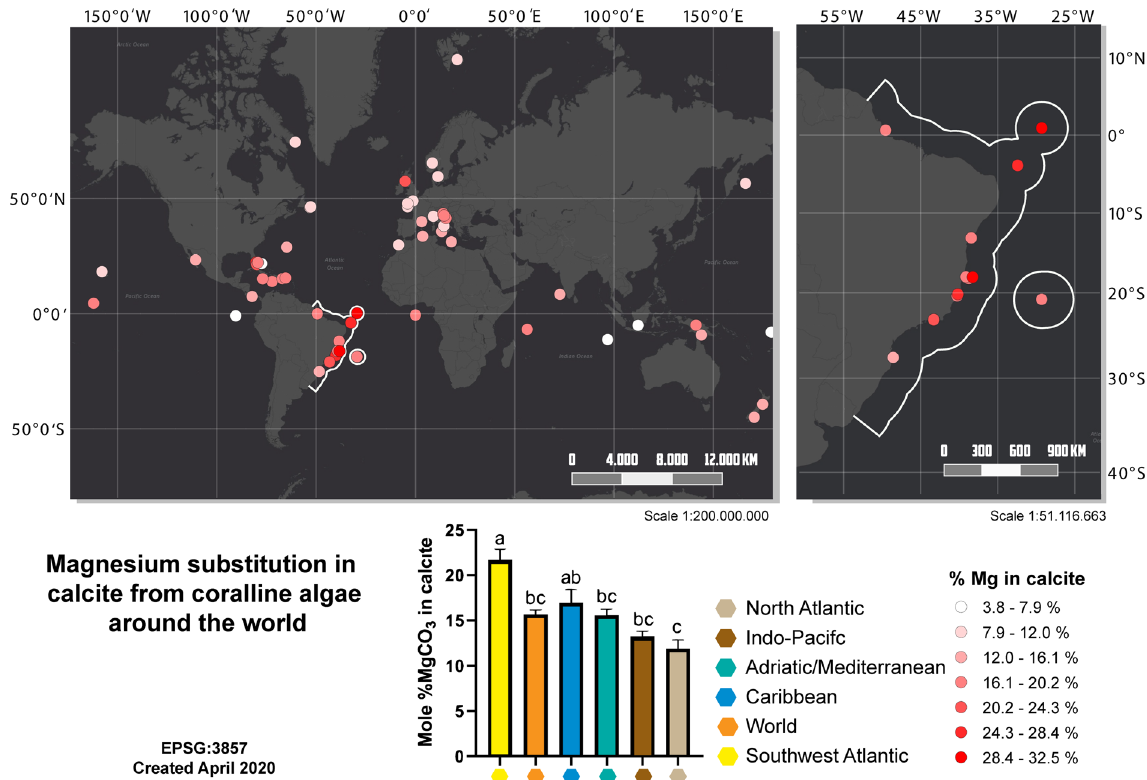
Figure 2. Map of world distribution of % Mg in calcite in coralline algae from four regions (North Atlantic Ocean, Indo-Pacific Ocean, Adriatic/Mediterrean Sea, Caribbean and Southwest Atlantic Ocean; upper left in the figure) ranging from 4 to 33% Mg in calcite; a detailed map of % Mg in calcite in coralline algae species analyzed in this study along the Brazilian shelf (upper righ in the figure); mean % Mg in calcite in coralline algae and standard deviation in several regions of world. Different letters are used to indicate statistically differences (p < 0.05) obtained through post-hoc Dunn’s test after the Kruskal–Wallis analysis (bellow in the figure). Both maps maps were obtained from ESRI database (https:// servi ces. arcgi sonli ne. com/ arcgis/ rest/ servi ces/ Canvas/ World_ Dark_ Gray_ Base/ MapSe rver) and the coordinates from the mineralogy analysis were standardized using EPSG: 3857-WGS 84/Pseudo-Mercator. Maps were produced with QGIS v3.4 (https:// www. qgis.